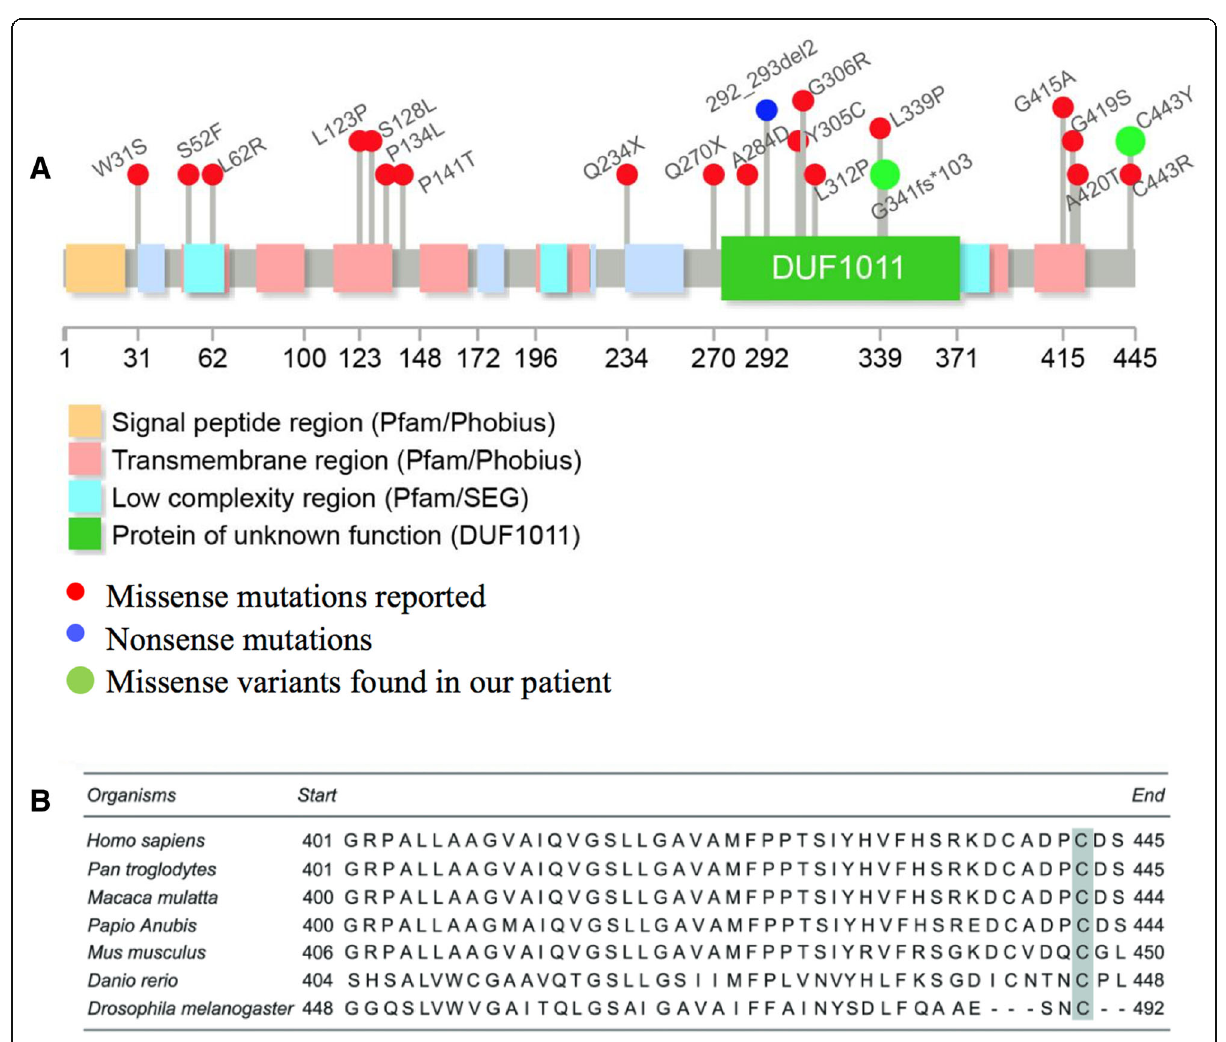
Fig. 2 a Functional domains and regions in SLC52A2 gene as indicated. Red dots: missense mutations; Blue dots: nonsense mutations; Green dots: missense variants found in our patient. b Evolutionary conservation of cysteine residue at position 443 (shade in grey) in the SLC52A2 gene among